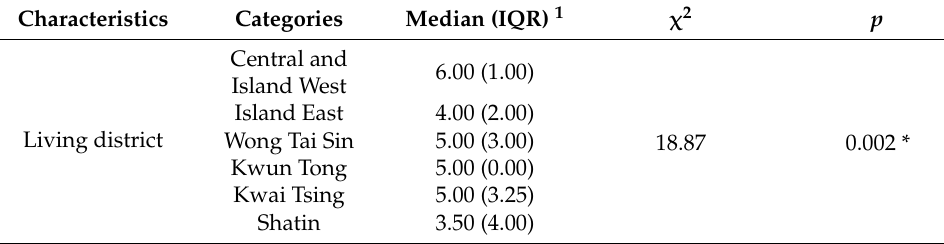
Table 6. Differences in loneliness level (total score) among districts of residence ( n =